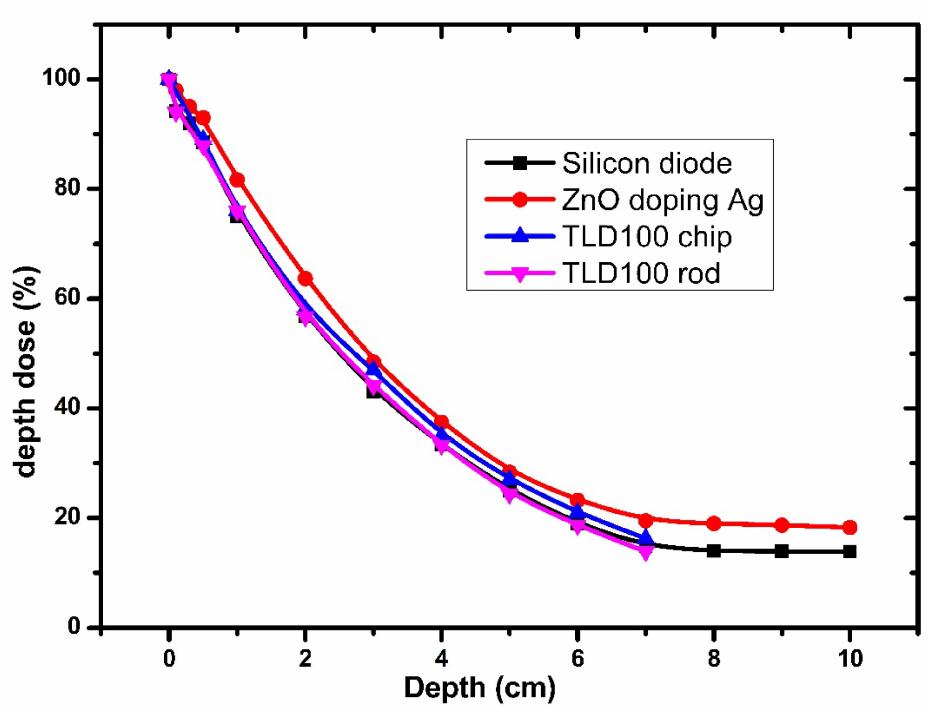
Figure 17. Percentage depth dose curve of the Perspex phantoms in 30 cm × 30 cm field size at 60 kVp of the X-ray energy with delivery dose 3